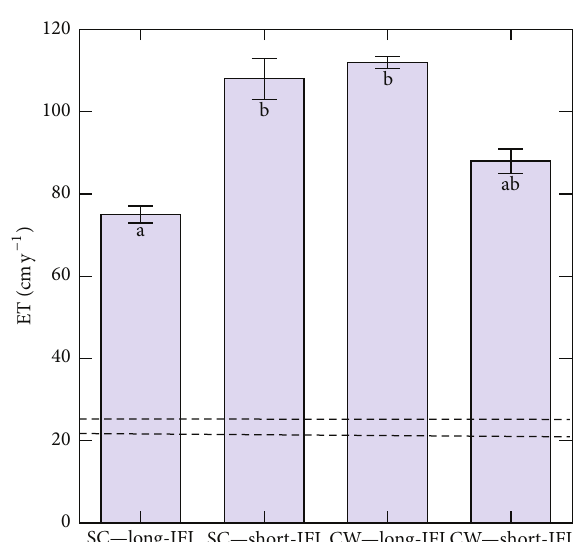
SC—long-IFI SC—short - IFI CW—long - IFI CW—short - IFI Figure 2: Annual evapotranspiration (ET) ± standard error. Values with the same letter are not significantly different ( 𝑝 < 0.05 ). The two horizontal dashed lines represent the range in annual average rainfall in the central valley of the Middle Rio Grande